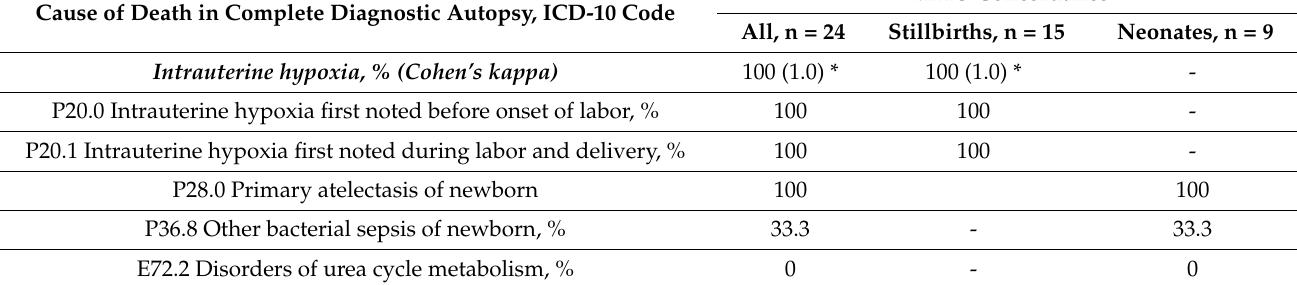
Table 3. Concordance rates of causes of deaths between complete diagnostic autopsy and MITS among all, stillbirths and neonates, employing underlining